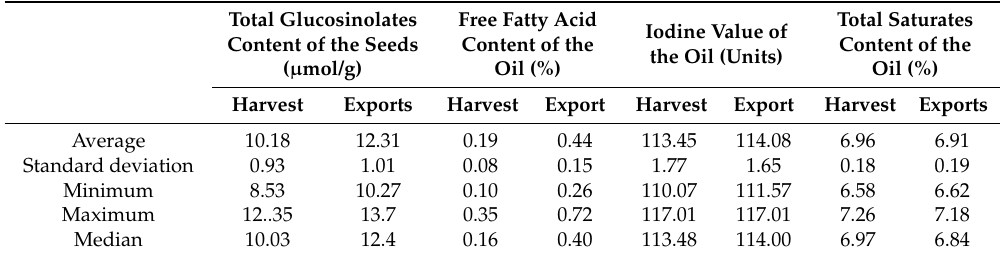
Table 4. Yearly mean average and standard deviation for harvest (HSD) and exports (ECD) samples of Canada No. 1, Canola for free fatty acid, total glucosinolates, and total saturates